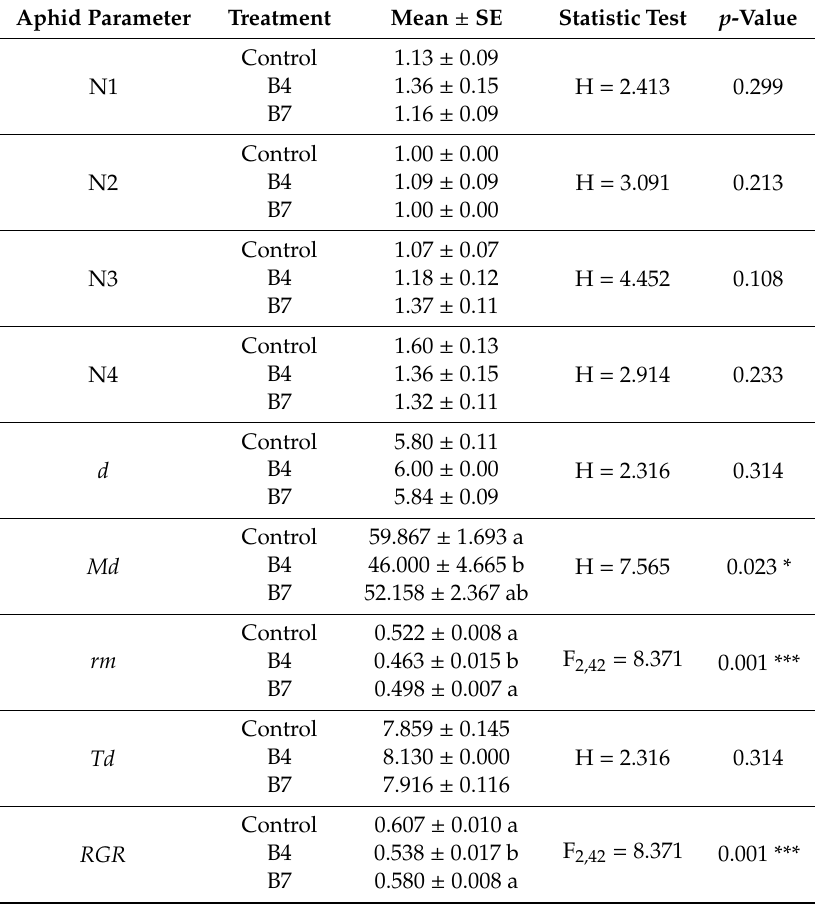
Biological parameters of Aphis gossypii reared on melon plants treated with BTH (benzo-(1,2,3)-thiadiazole-7-carbothioic-acid S-methyl ester) to the point of run-o ff , four (B4), and